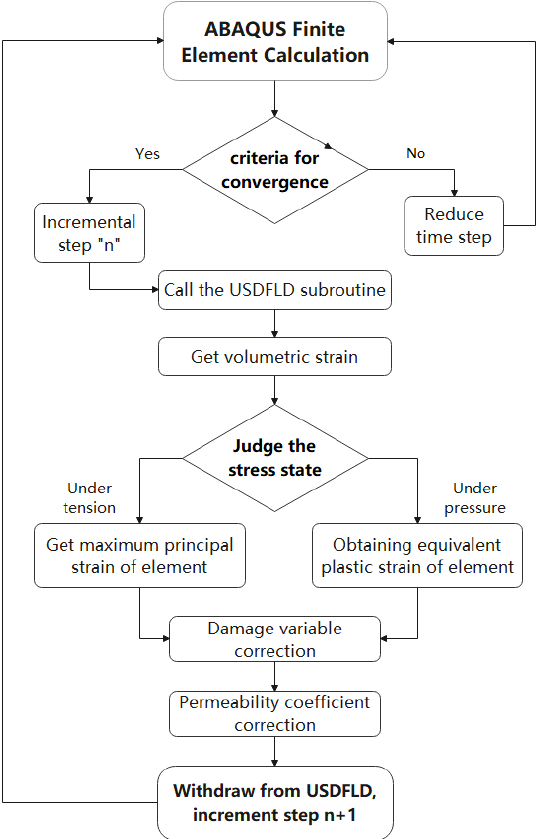
Figure 2. Flowchart of seepage/stress-damage coupling